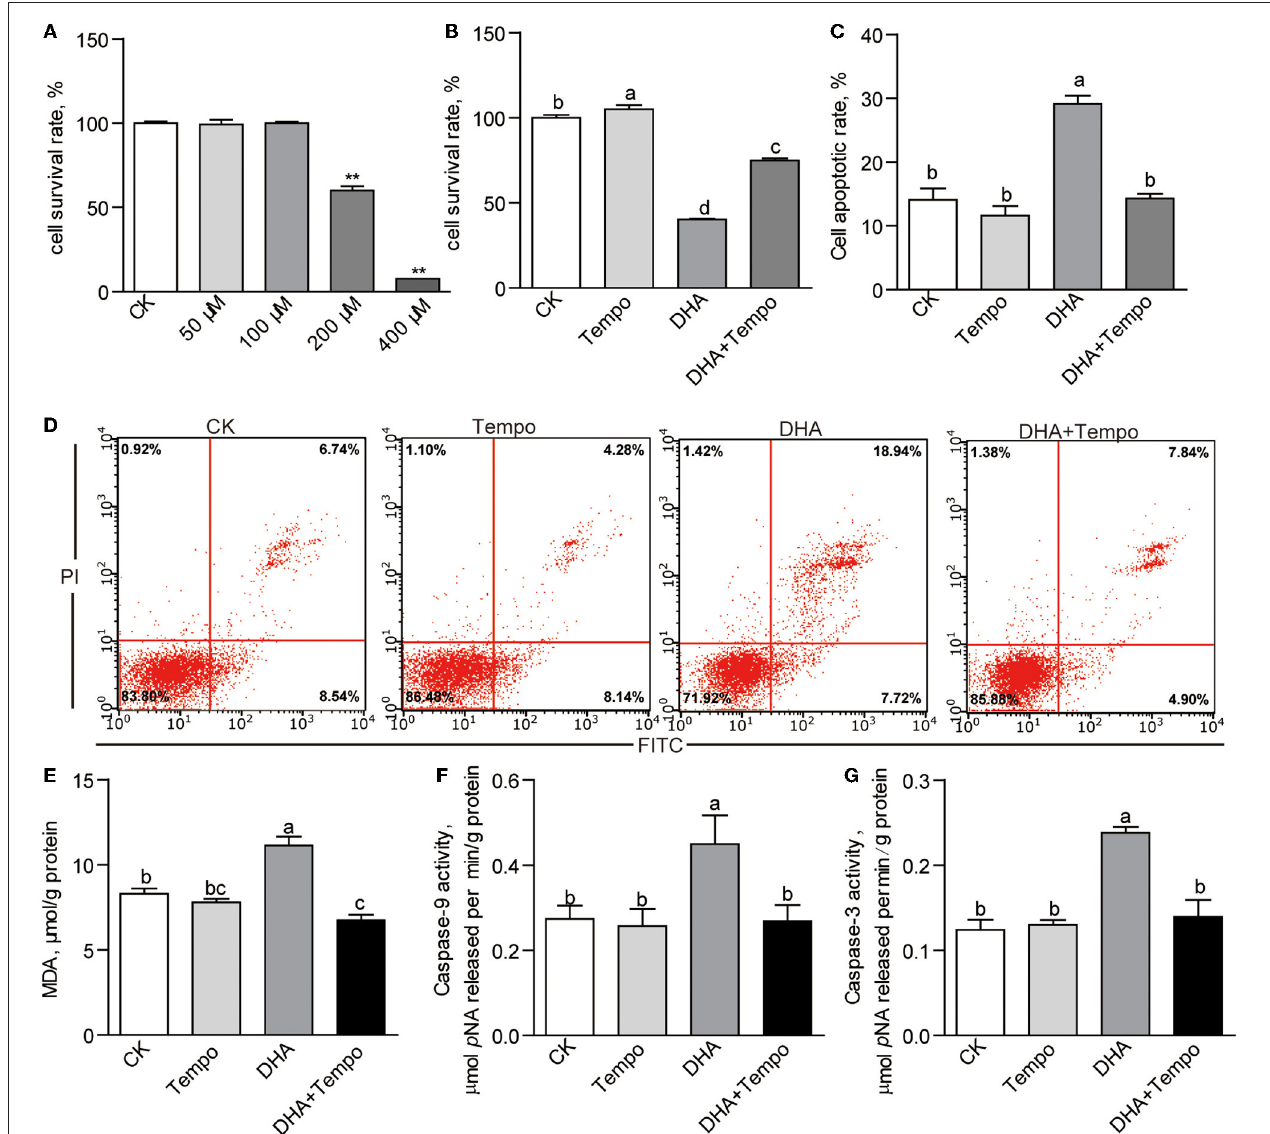
FIGURE 6 | The effects of antioxidant, 4-hydroxy-Tempo (Tempo), on DHA cytotoxicity in ZFL cells. (A) The cell survival rates of ZFL cells treated with increasing concentrations of DHA for 24h. (B) The cell survival rates and (C) the cell apoptotic rates of ZFL cells co-treated with DHA and tempo for 24h. (D) The representative images of cell apoptosis of ZFL cells co-treated with DHA and tempo for 24h. (E) The MDA levels in ZFL cells co-treated with DHA and tempo for 24h. The activities of (F) caspase-9 and (G) caspase-3 in ZFL cells co-treated with DHA and tempo for 24h. Values are means ± SEMs ( n = 3 ∼ 8 biological replicates). The mean values without a common letter are significantly different, p < 0.05. ** p <